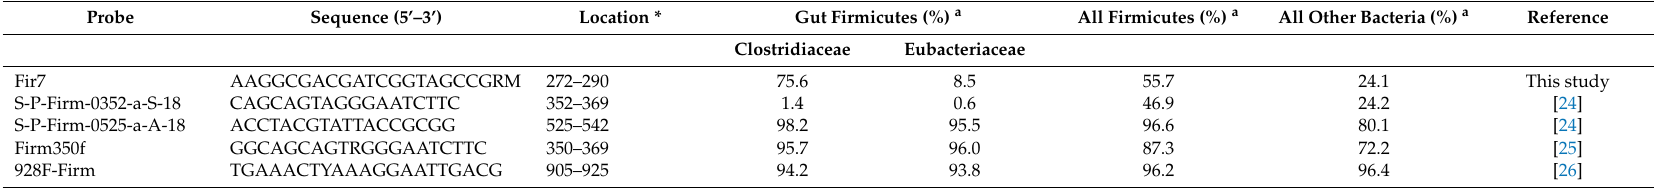
Table 4. Comparison of probes from the current study with previously reported Firmicutes-specific probes.